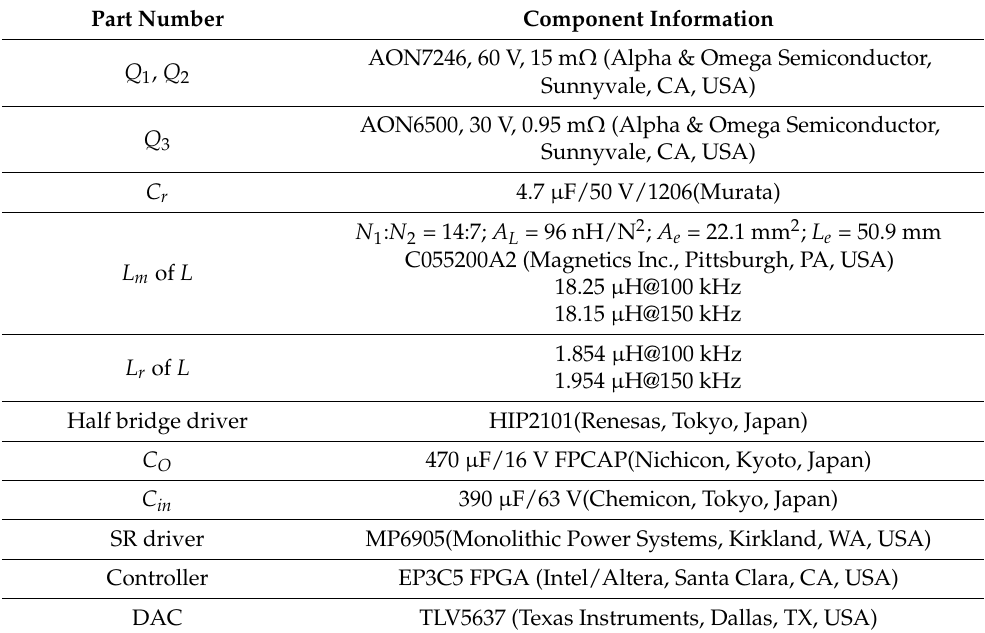
Table 2. Key components information of the prototype circuit.